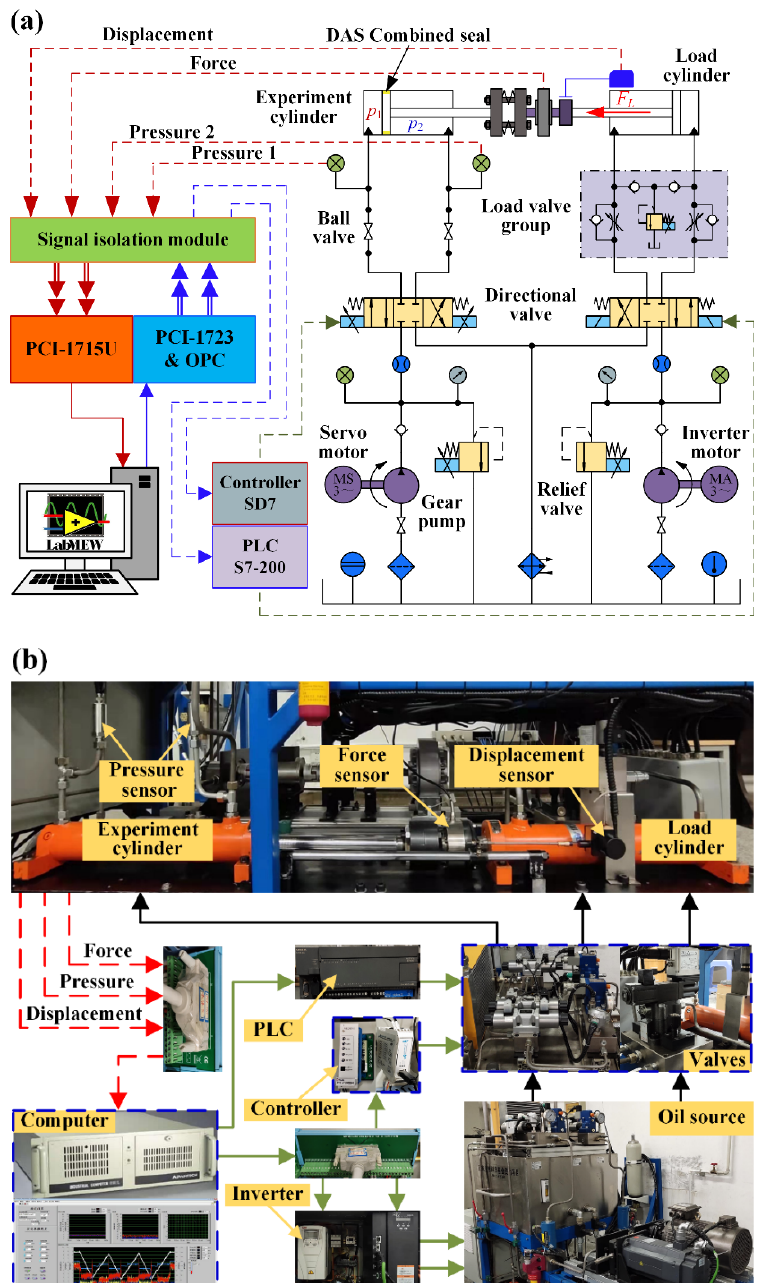
Figure 13. Experiment platform: ( a ) Structural schematic diagram; ( b ) actual composition diagram.